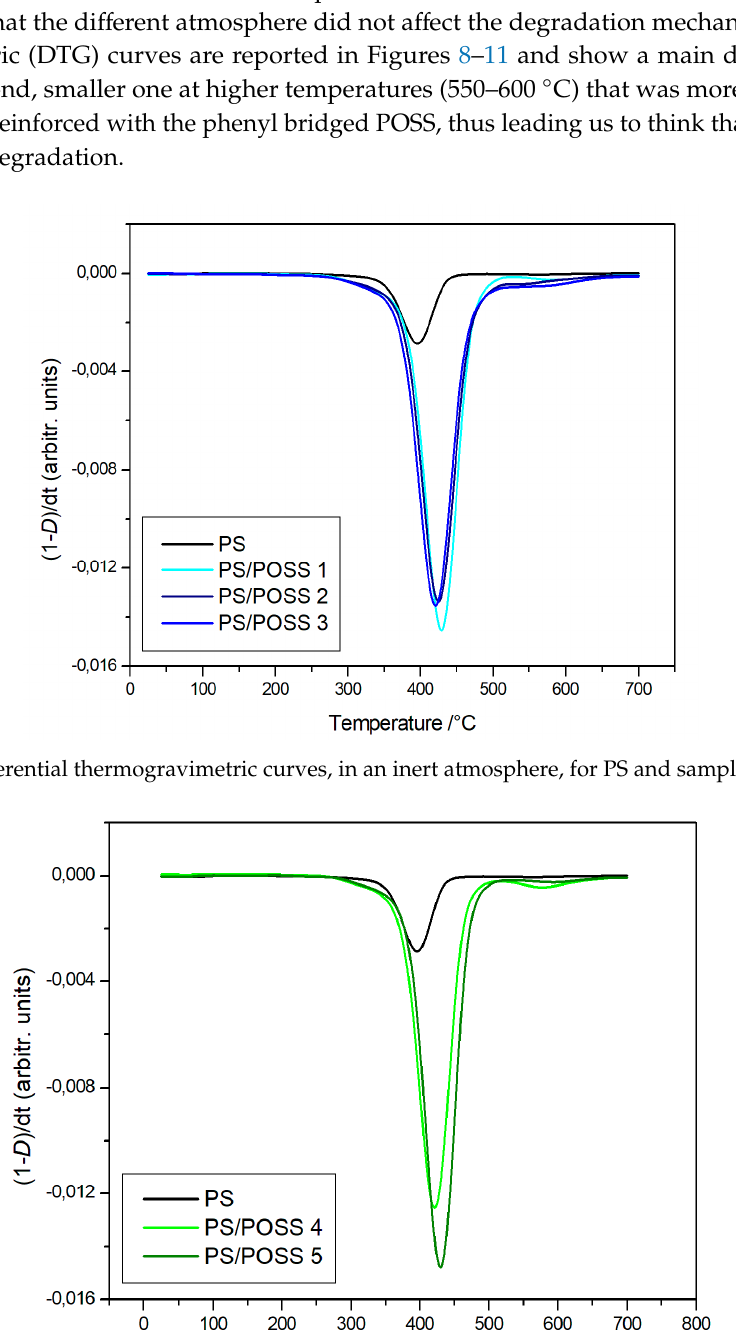
Figure 7. SEM images of PS/POSS 5 nanocomposites.